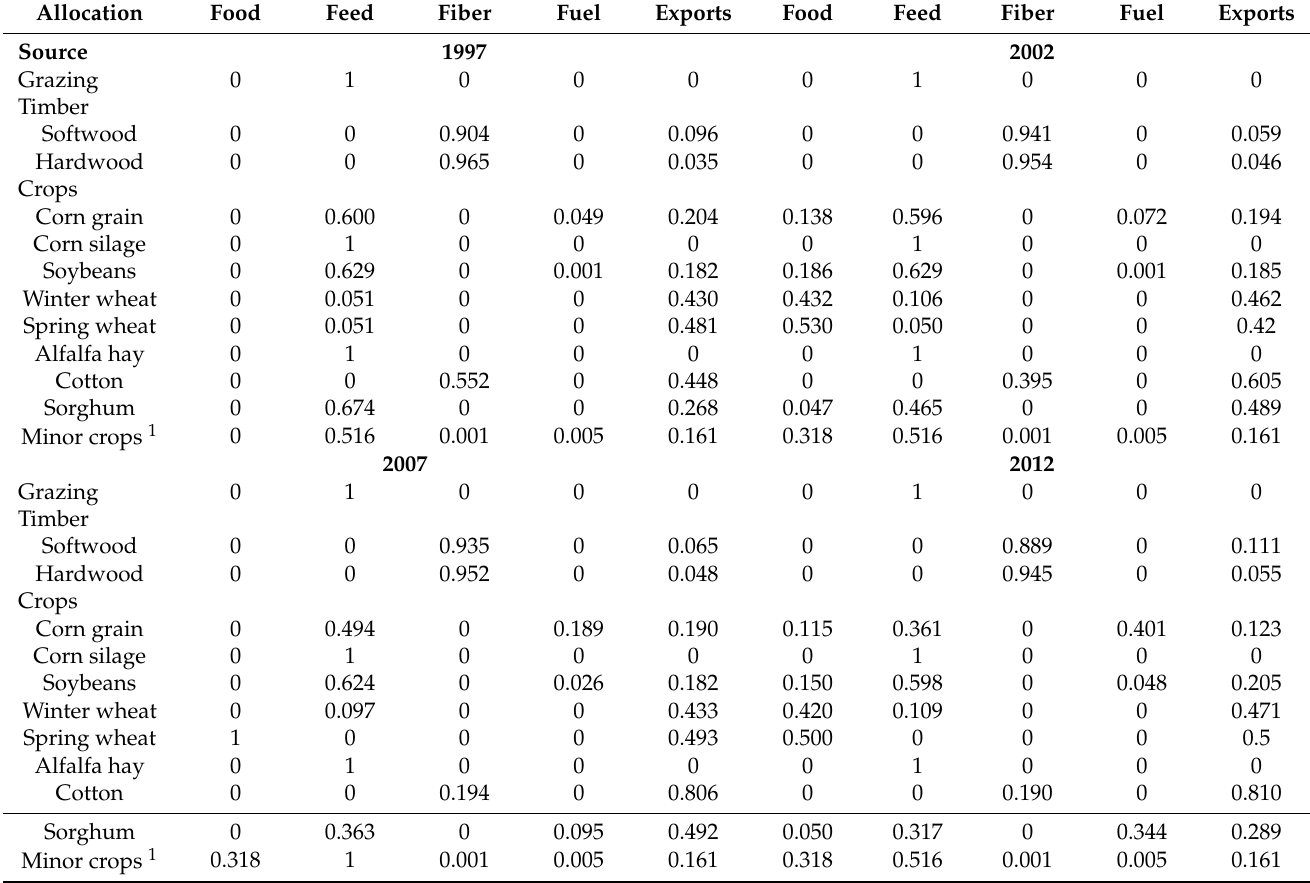
Table 2. Proportions of specific major crops, timber products and livestock grazing allocated to food, livestock feed, biofiber, biofuel and exports in 1997, 2002, 2007 and